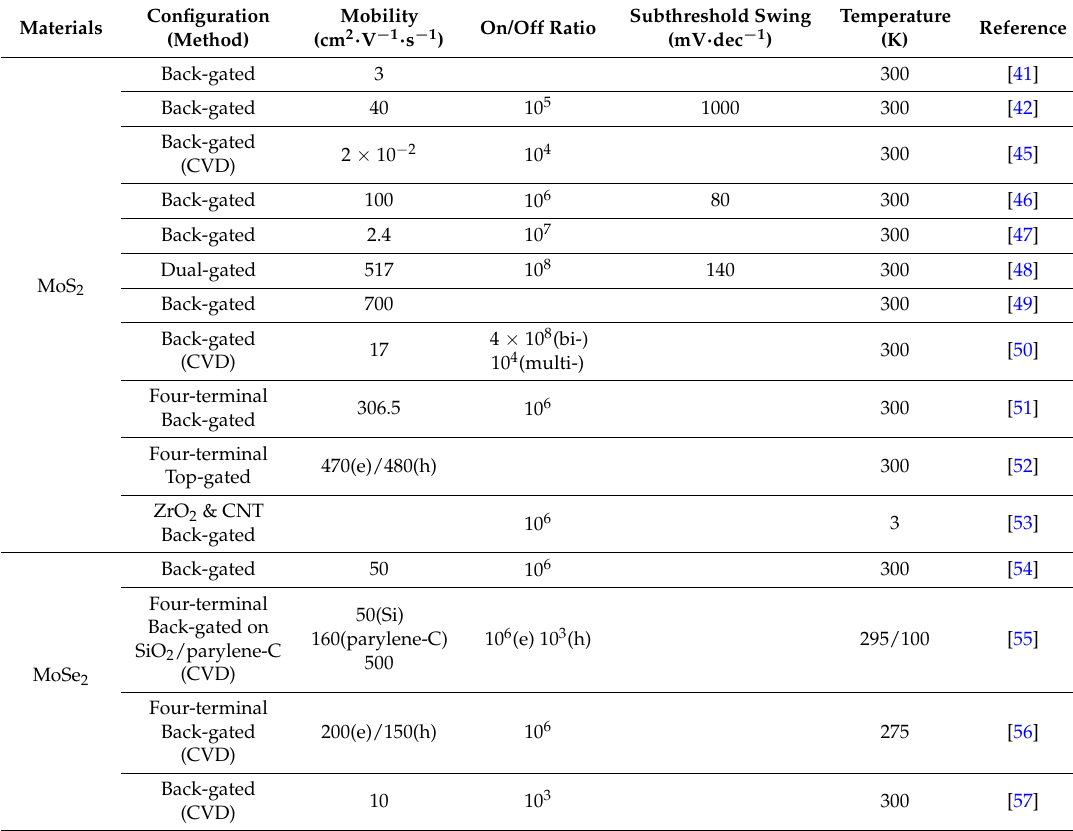
Table 2. Performance of FETs based on multilayer TMDCs prepared by mechanical exfoliation and by chemical vapor deposition (as noted with CVD). Electron mobility is compiled here (or denoted by e). The hole mobility is denoted by